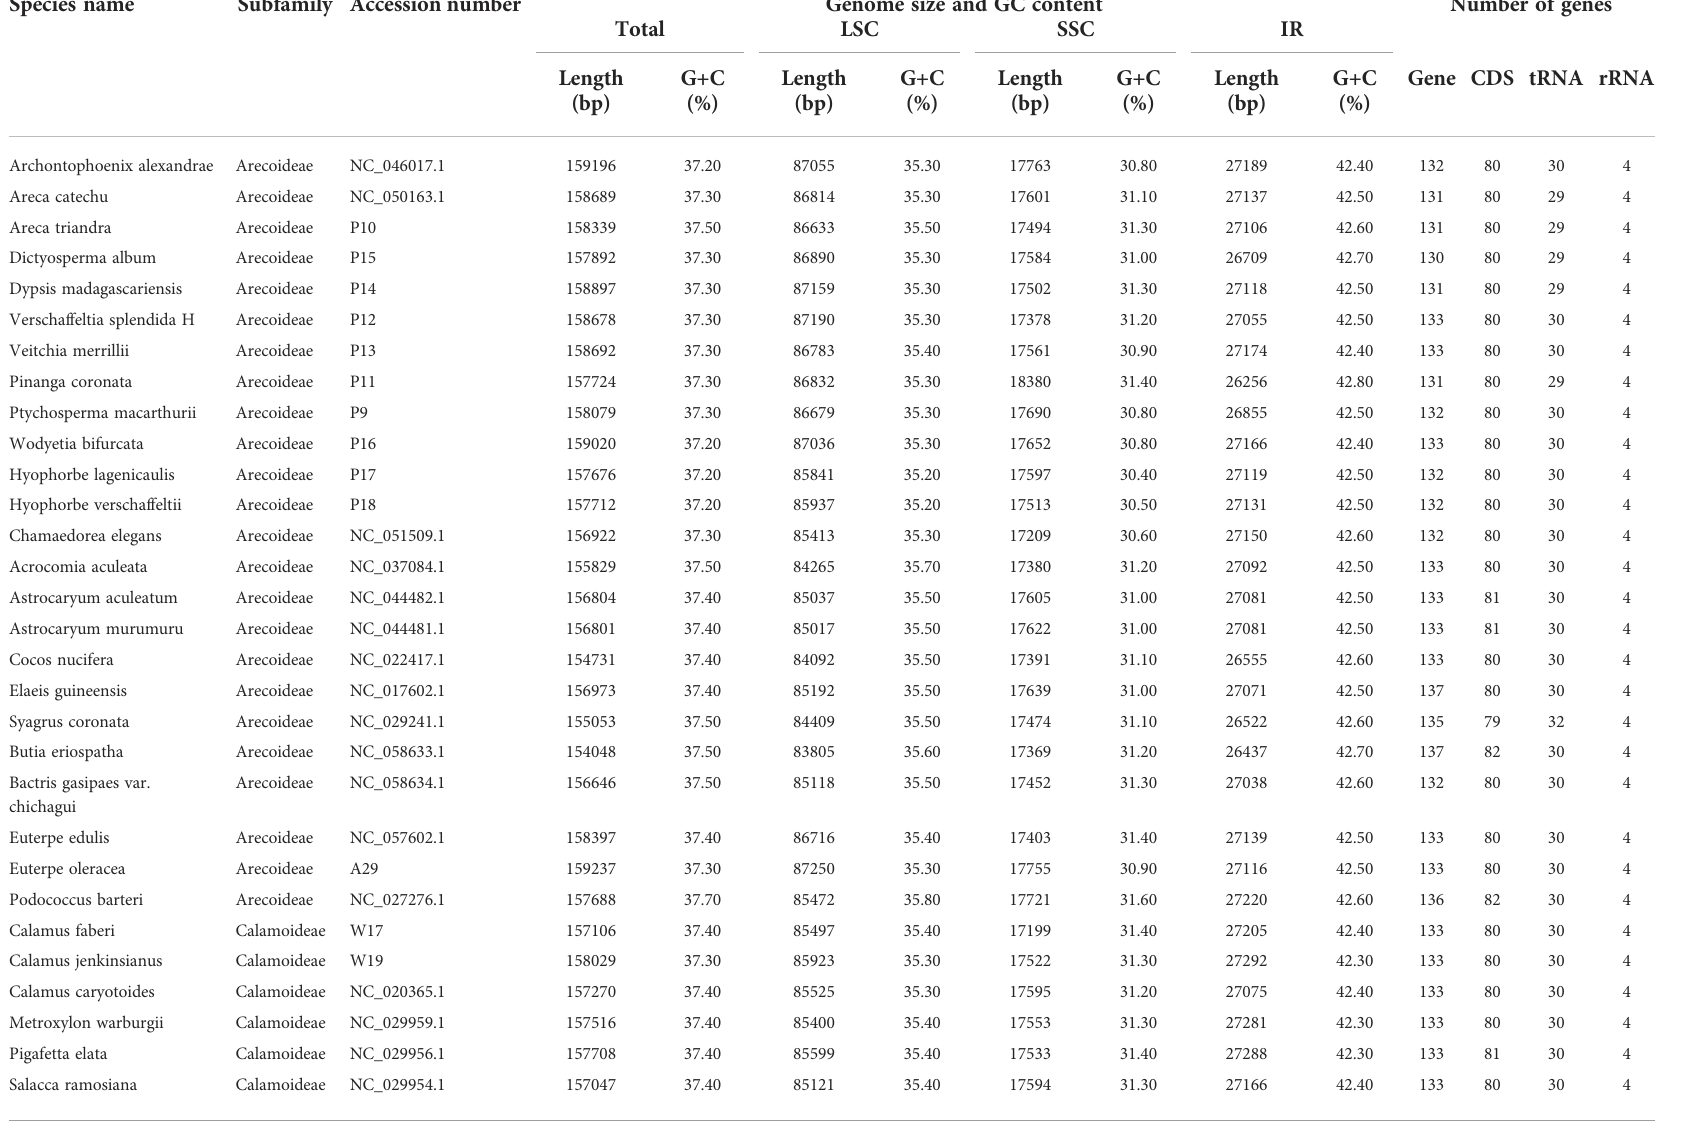
TABLE 2 Summary of the main characteristics of plastomes in Arecaceae and related